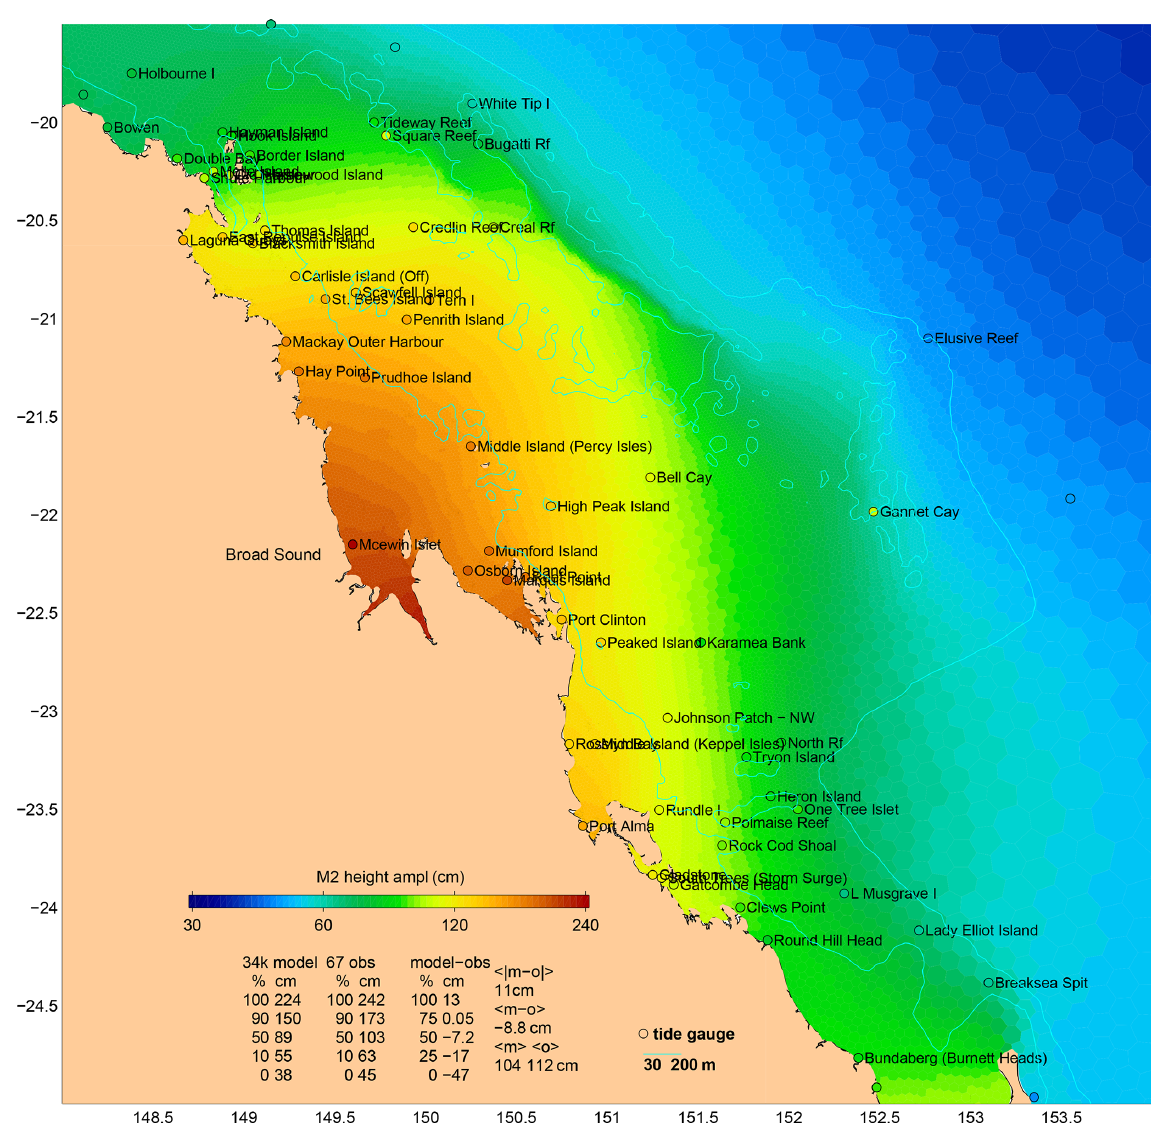
Figure 12. Amplitude of the M2 height for the southern Great Barrier Reef region; otherwise like Fig.